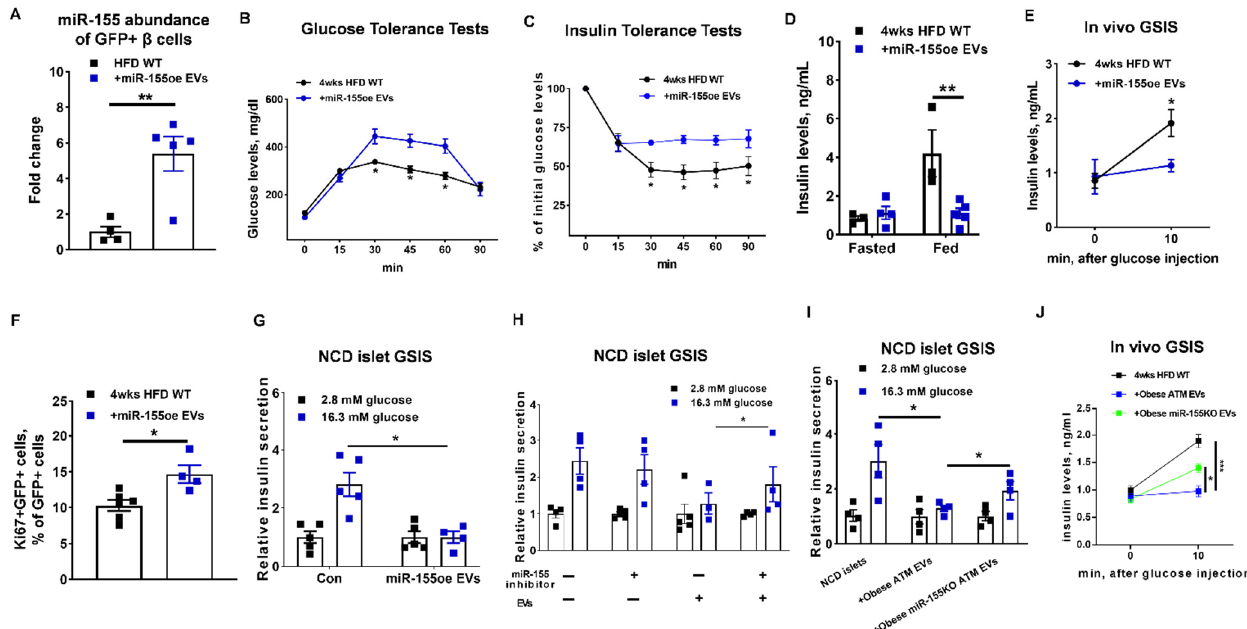
Figure 6. miR-155 is a key molecule contributing to the ability of obese ATM EVs to regulate β Cell responses. After 4 weeks treatment of miR-155-enriched BMDM EVs (miR-155oe EVs), the miR-155 expression of GFP+ cells ( A ), glucose and insulin tolerance tests ( B and C ), insulin levels after 16 h fasting or feeding ( D ), and glucose-induced insulin levels ( E ) of HFD MIPGFP-Mki67 recipients were measured. ( F ) The population of ki67 + GFP+ cells in the islets of HFD MIPGFP-Mki67 mice after 4 weeks treatment of miR-155oe EVs. ( G ) The effect of miR-155oe EVs on NCD islet GSIS. ( H ) The GSIS of NCD islets treated with miR-155 inhibitor or obese ATM EVs. ( I ) The GSIS of NCD islets treated with EVs derived from either obese ATMs or obese miR-155KO ATMs. ( J ) Effect of miR-155 depletion on the ability of obese ATM EVs to regulate GSIS of HFD-fed mice. For B–G, control islets or mice were treated with DicerKO BMDM EVs. Data are presented as the mean ± SEM. B, C, E, and J, N = 5 per group; G-I, N = 4 per group. * p < 0.05, ** p < 0.01, *** p < 0.001, Student’s t test ( A , E , and F ), one-way ( J ) or two-way ( B – D , and G – I ) ANOVA.